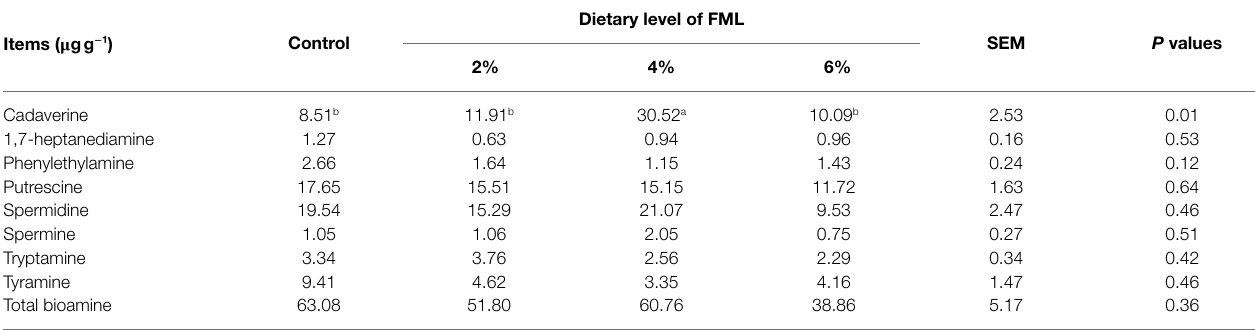
TABLE 6 | Effects of dietary supplementation with fermented Mao-tai lees (FML) on colonic bioamine concentrations of weaned